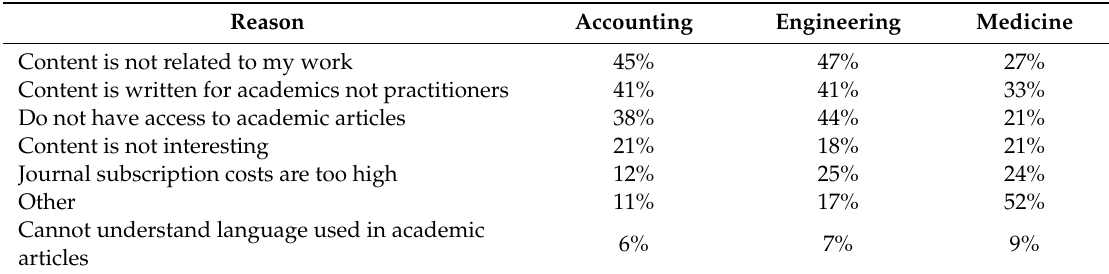
Table 5. Reasons why participants do not or rarely read academic research